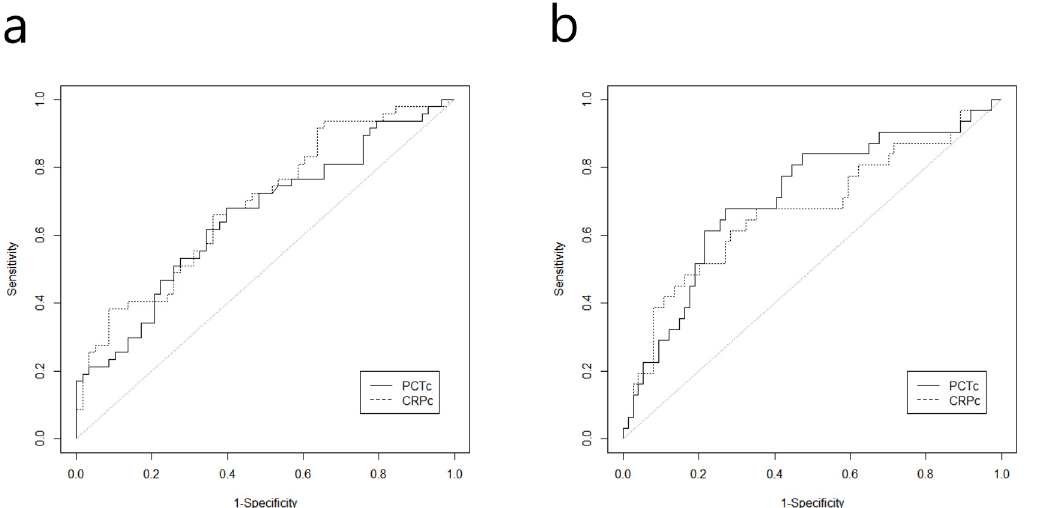
Fig 1. (a) Receiver operating characteristic (ROC) curves for procalcitonin (PCTc) and C-reactive protein (CRPc) clearance predict treatment failure. (b) Receiver operating characteristic (ROC) curves for procalcitonin (PCTc) and C-reactive protein (CRPc) clearance predict 28-day mortality. The test for AUC difference between the two markers had a p-value > 0.2 for both treatment failure and 28-day